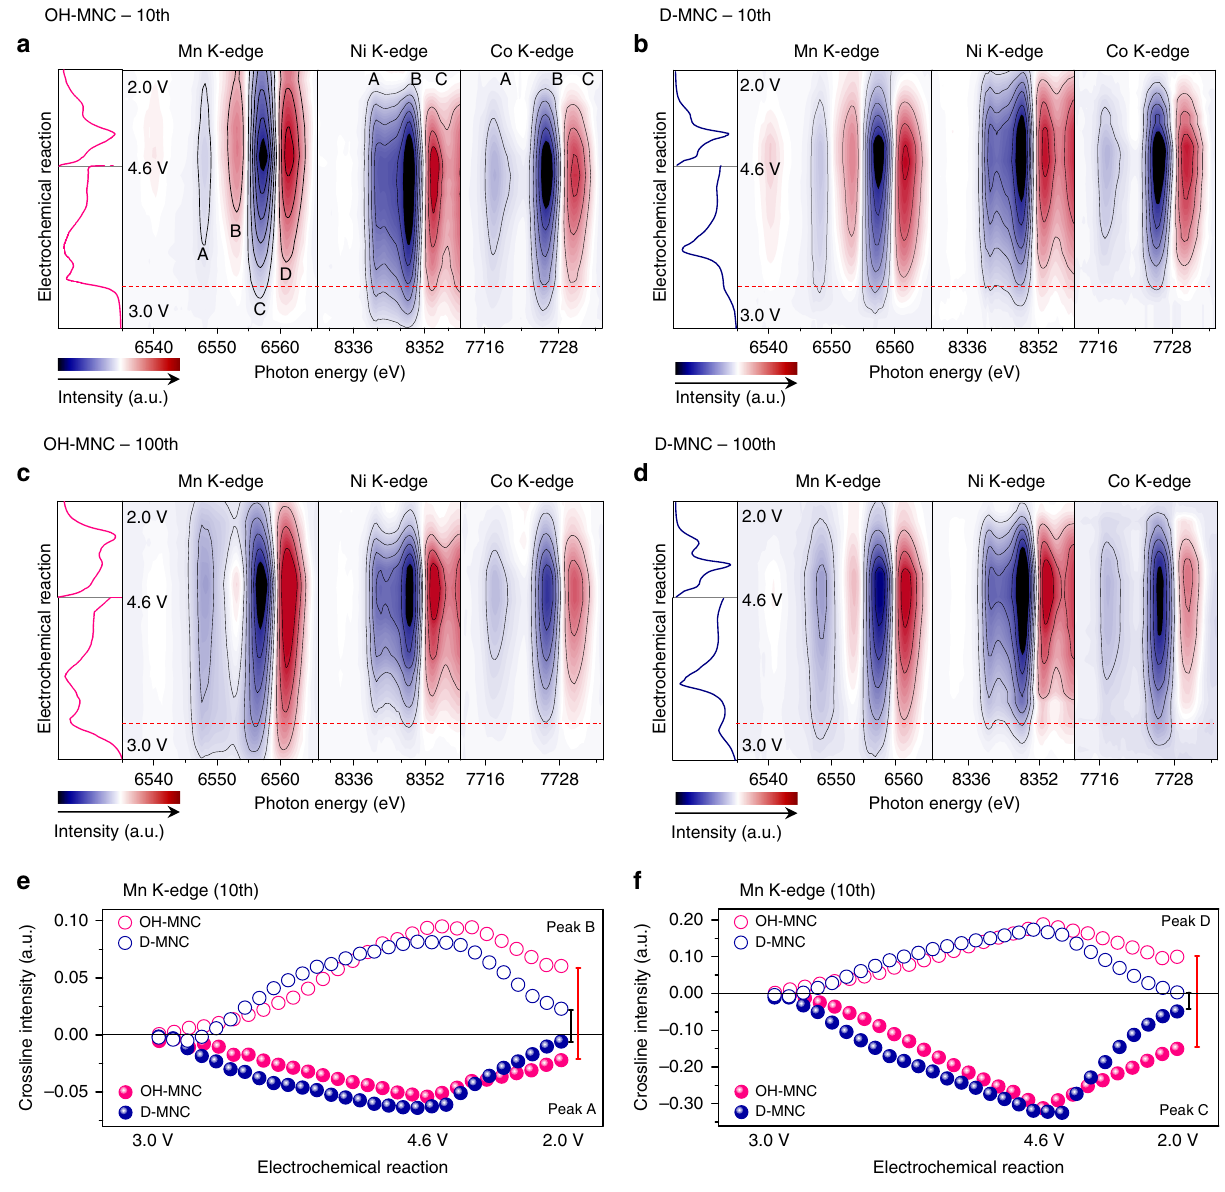
Fig. 2 Transition-metal K-edge operando XANES variation during cycling. Mn, Ni, and Co K-edge operando XANES spectra (2D contour plot) and voltage pro fi les of a OH-MNC 10, b D-MNC 10th, c OH-MNC 100th, and d D-MNC 100th; Crossline intensity of Mn K-edge operando XANES spectra peaks e A and B; f C and D during 10th cycle; Electrodes were cycled at 0.5C-rate charge 1.0C-rate discharge